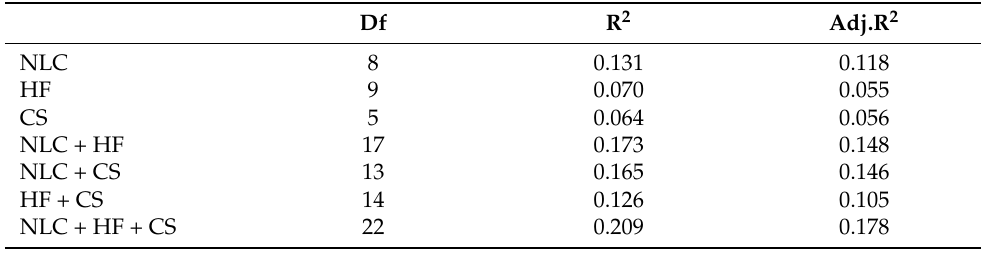
Table A6. Variance partitioning of the mite assemblage RDA by three explanatory variables: natural land cover (NLC), human footprint (HF), and climate–space